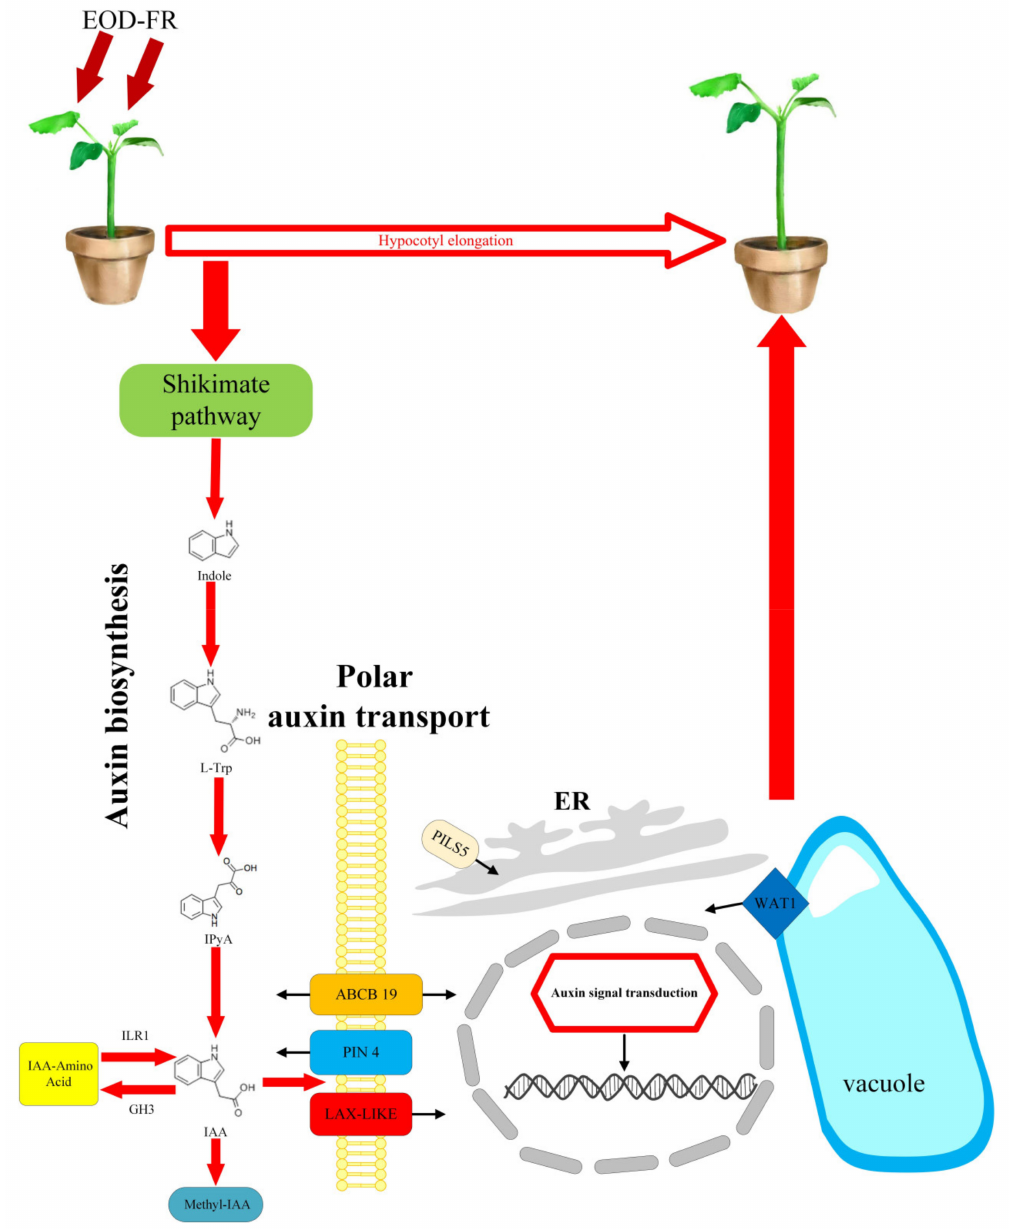
Figure 4. Hypothetical model of auxin-induced hypocotyl elongation in pumpkin under EOD-FR treatment. The figure depicts several auxin-related biological processes and reactions. Arrows indicate the directions of catalytic reactions or